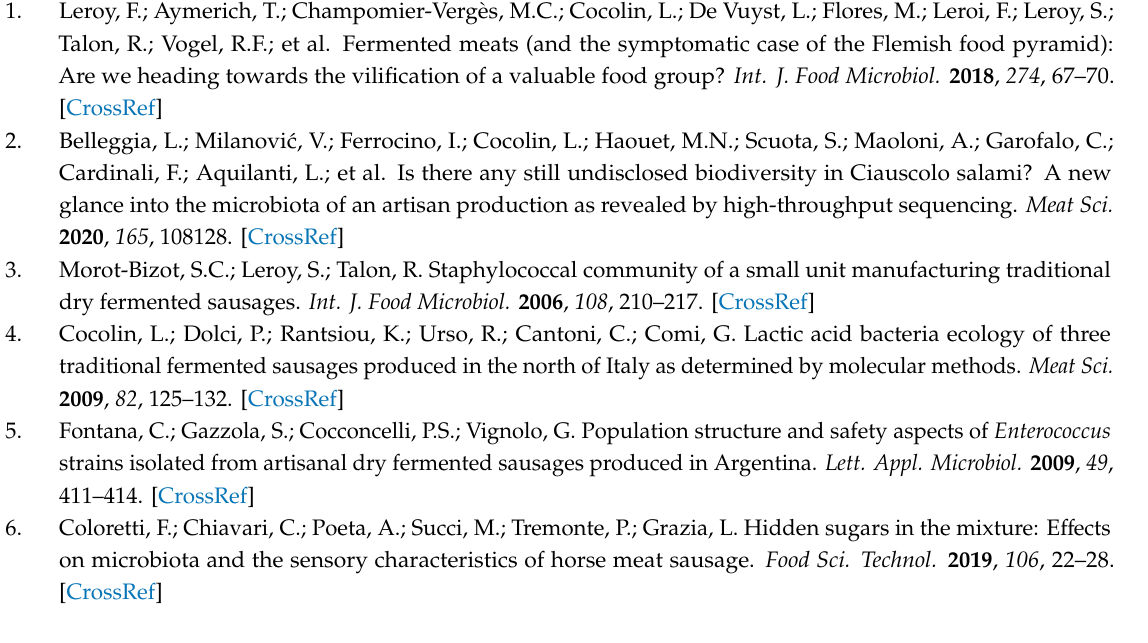
sp., Table S10. Alpha-diversity metrics based on the relative abundances of bacterial species found during less conventional meat fermentation processes (replicates 1 and 2) at days 0 and 7, through (GTG) 5 -PCR fingerprinting of genomic DNA. The Simpson (D) and Pielou (Je) indexes were calculated for all samples to measure their diversity and evenness,